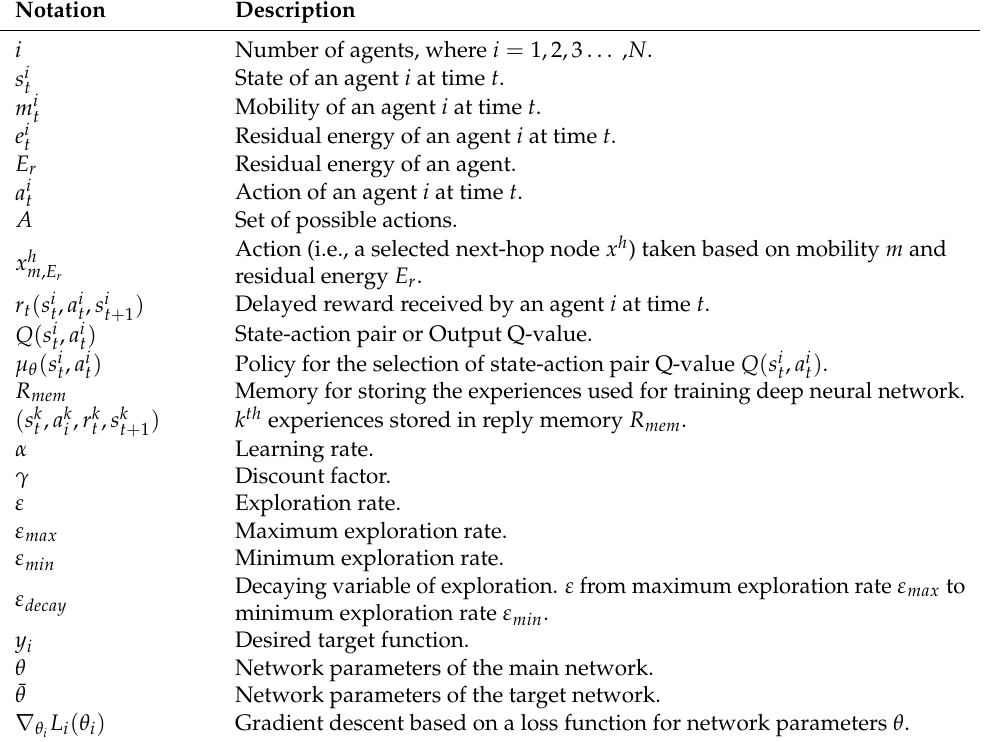
Table 2. Routing